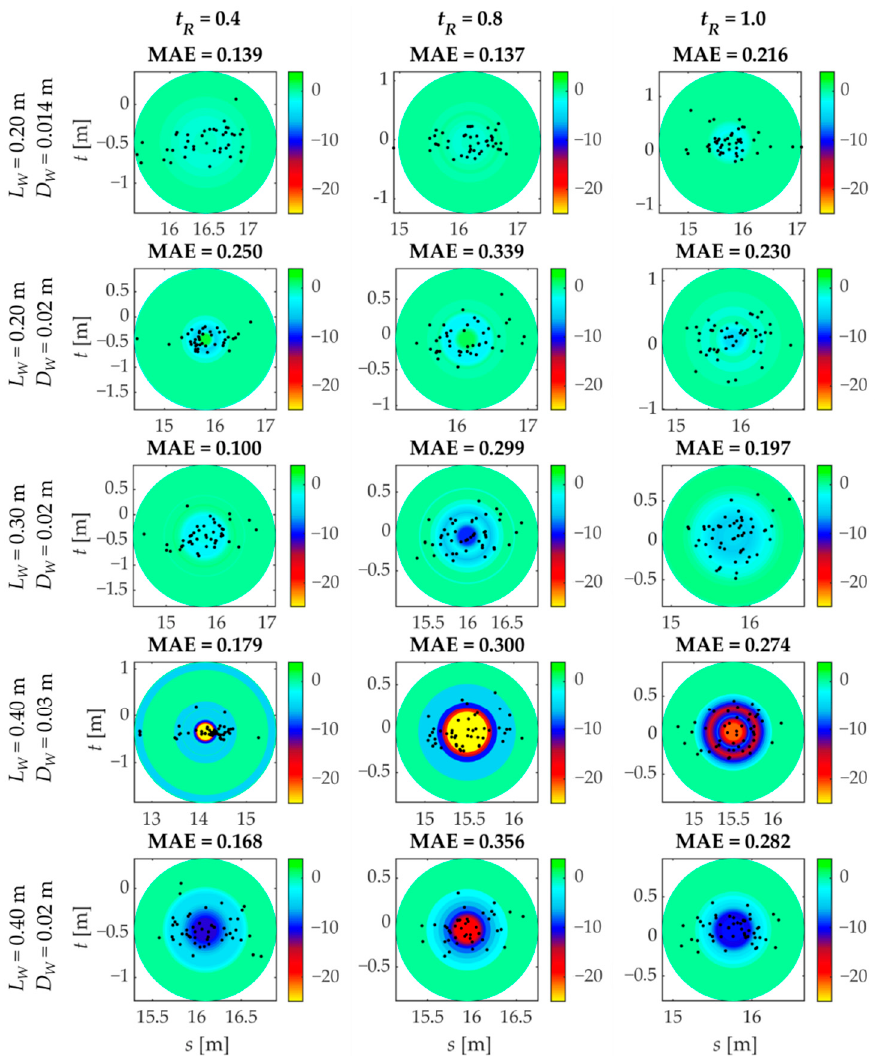
Figure 13. Difference of concentration [kg m − 2 ] for the S-shaped flume with narrowing. Black dots are the centers of mass of the experimental logs. Parameters on the left are the same for each column.